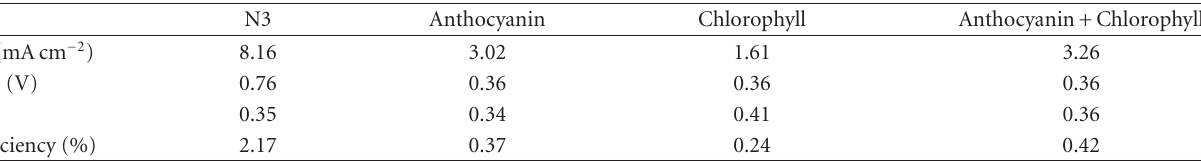
Table 2: The performance parameters of DSSCs with di ff erent dyes.